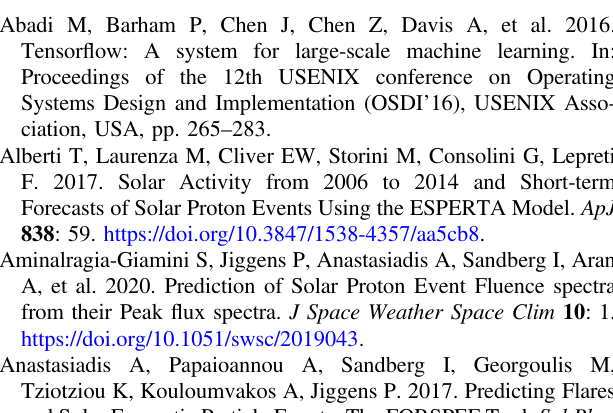
Table S1 . The 26 parameters derived from the heliolongi- tude and the SXR time-series of each fl are used as input in the neural network model. Figure S1 . One of the more typical NP Events with a minor enhancement in lower proton energies and mainly background noise in higher energies. Figure S2 . Similarly to S1, another typical NP Event with slightly higher intensities at low energies. Figure S3 . A medium intensity NP Event which exhibits enhancement up to the 166 MeV channel. Figure S4 . The most intense NP Event with the highest Peak Flux reaching ~300 p/(cm 2 (cid:4) s (cid:4) sr (cid:4) MeV) for the 6 MeV channel. However, higher energies are again mostly if not entirely